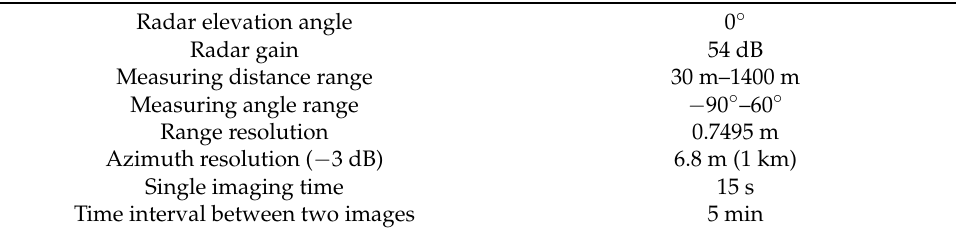
Table 1. SAR data acquisition parameters.